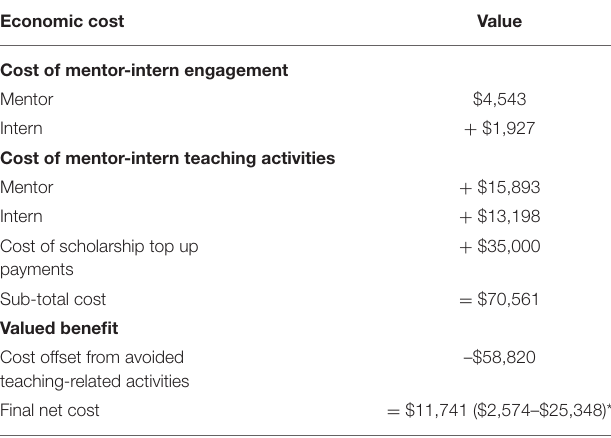
TABLE 2 | Costs and valued